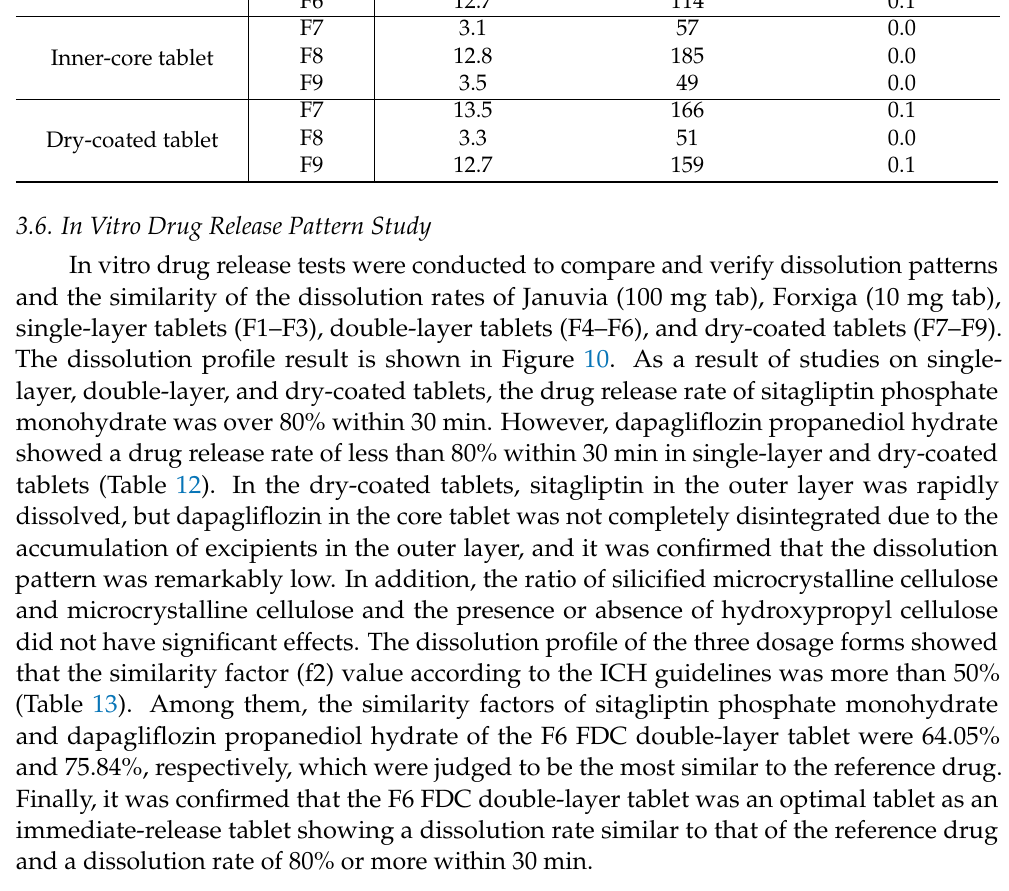
Table 12. In vitro dissolution test of the reference drug and sitagliptin-dapagliflozin FDC tablets in pH 6.8 medium. The data are expressed as the mean ± SD ( n =